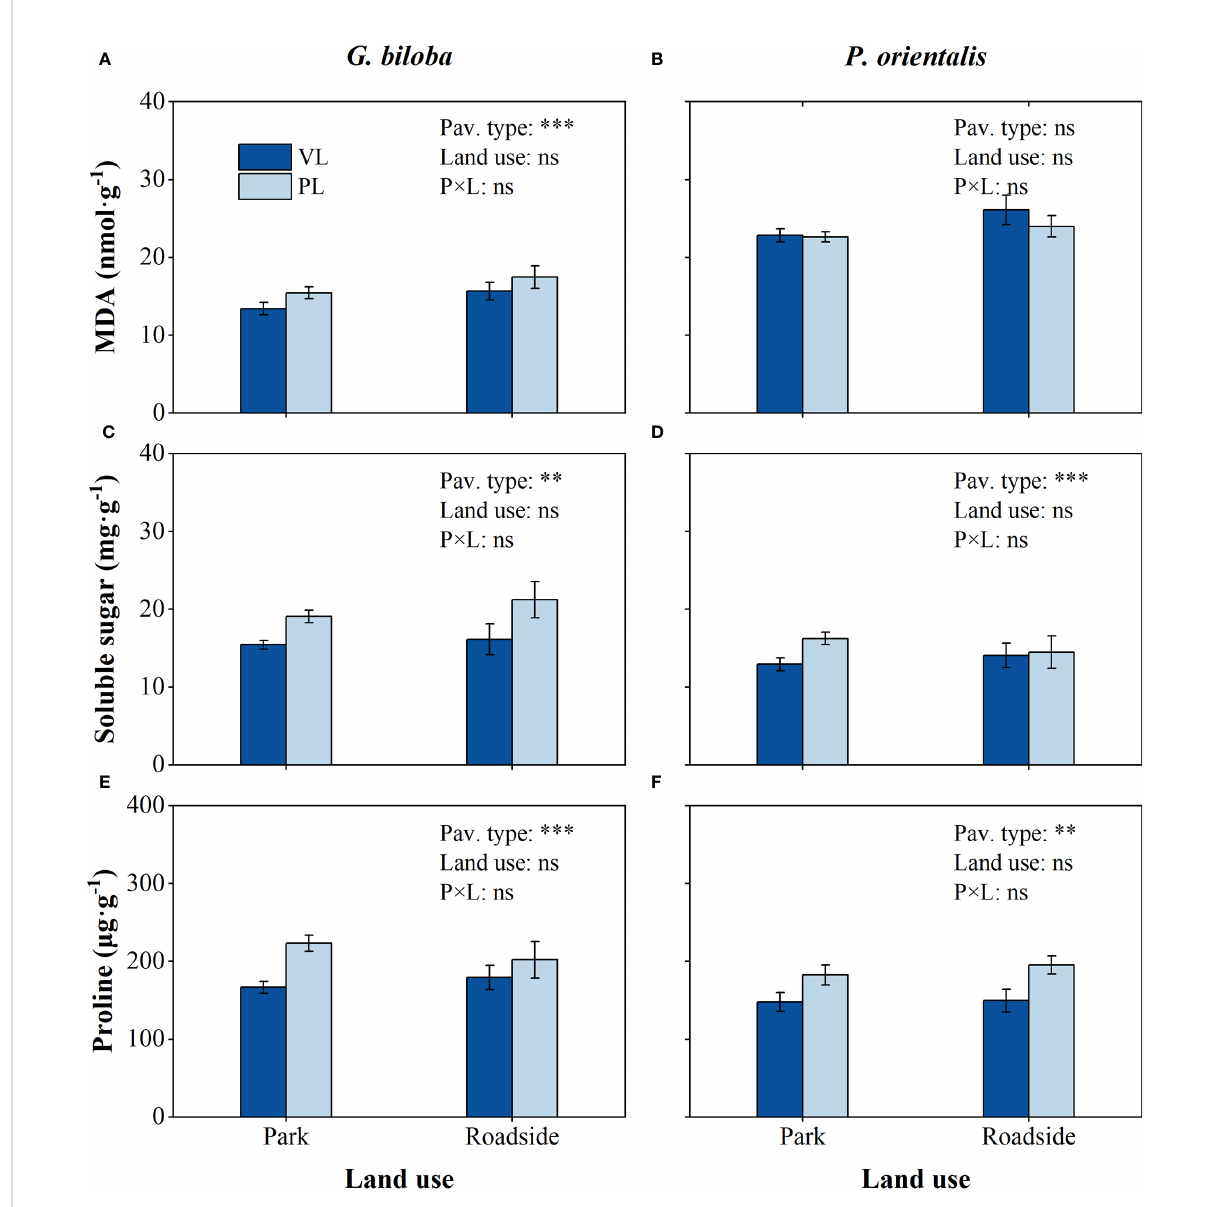
FIGURE 7 Results from the linear mixed-effects model (LMM) testing for the differences in the content of Malondialdehyde (MDA) (A, B) , soluble sugar (C, D) , and proline (E, F) vs. the pavement type (VL, vegetated land; PL, paved land), land use (park and roadside), and their interactions. **, P < 0.01; ***, P < 0.001; ns, not signi fi cant. Data represent mean ±